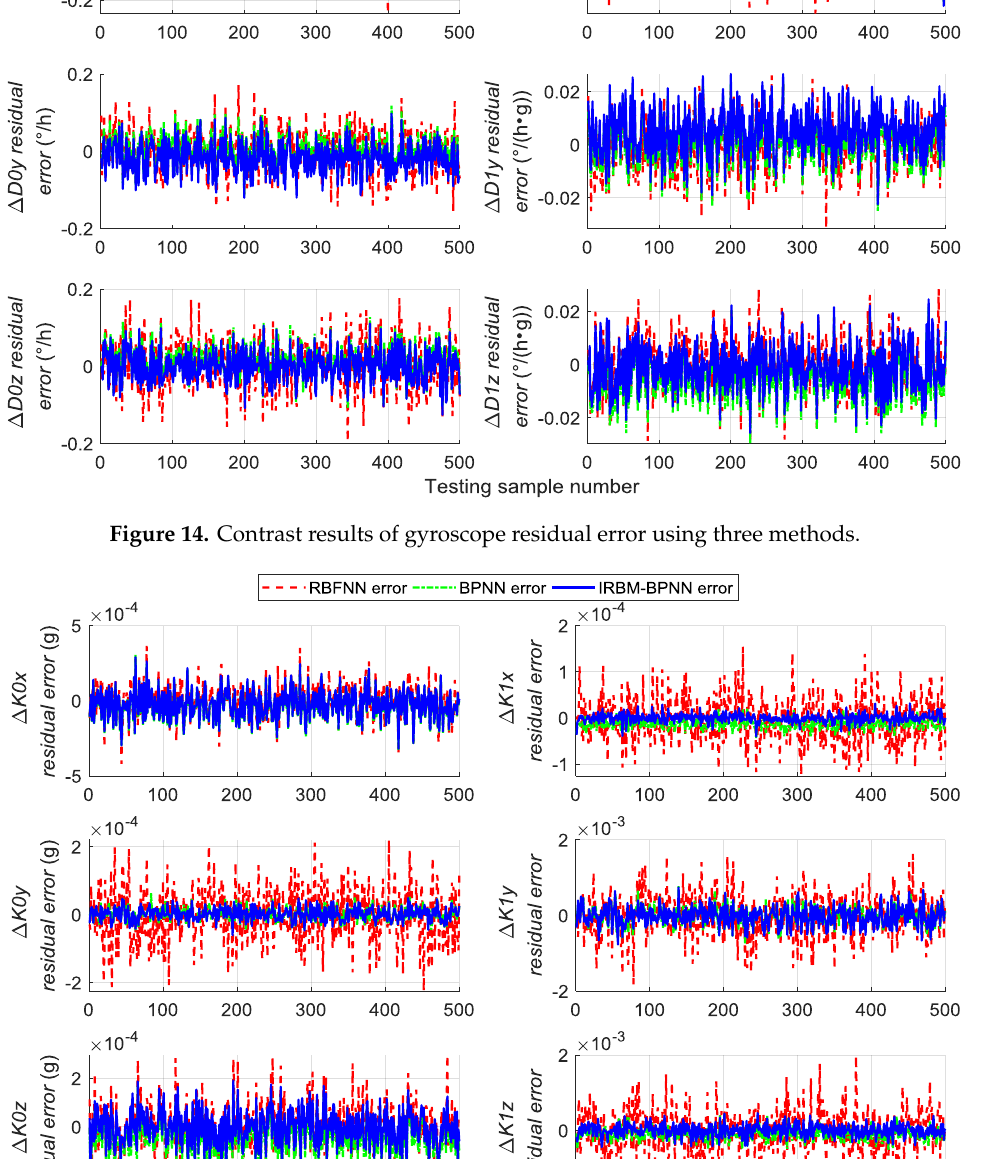
Figure 15. Contrast results of accelerometer residual error using three methods.